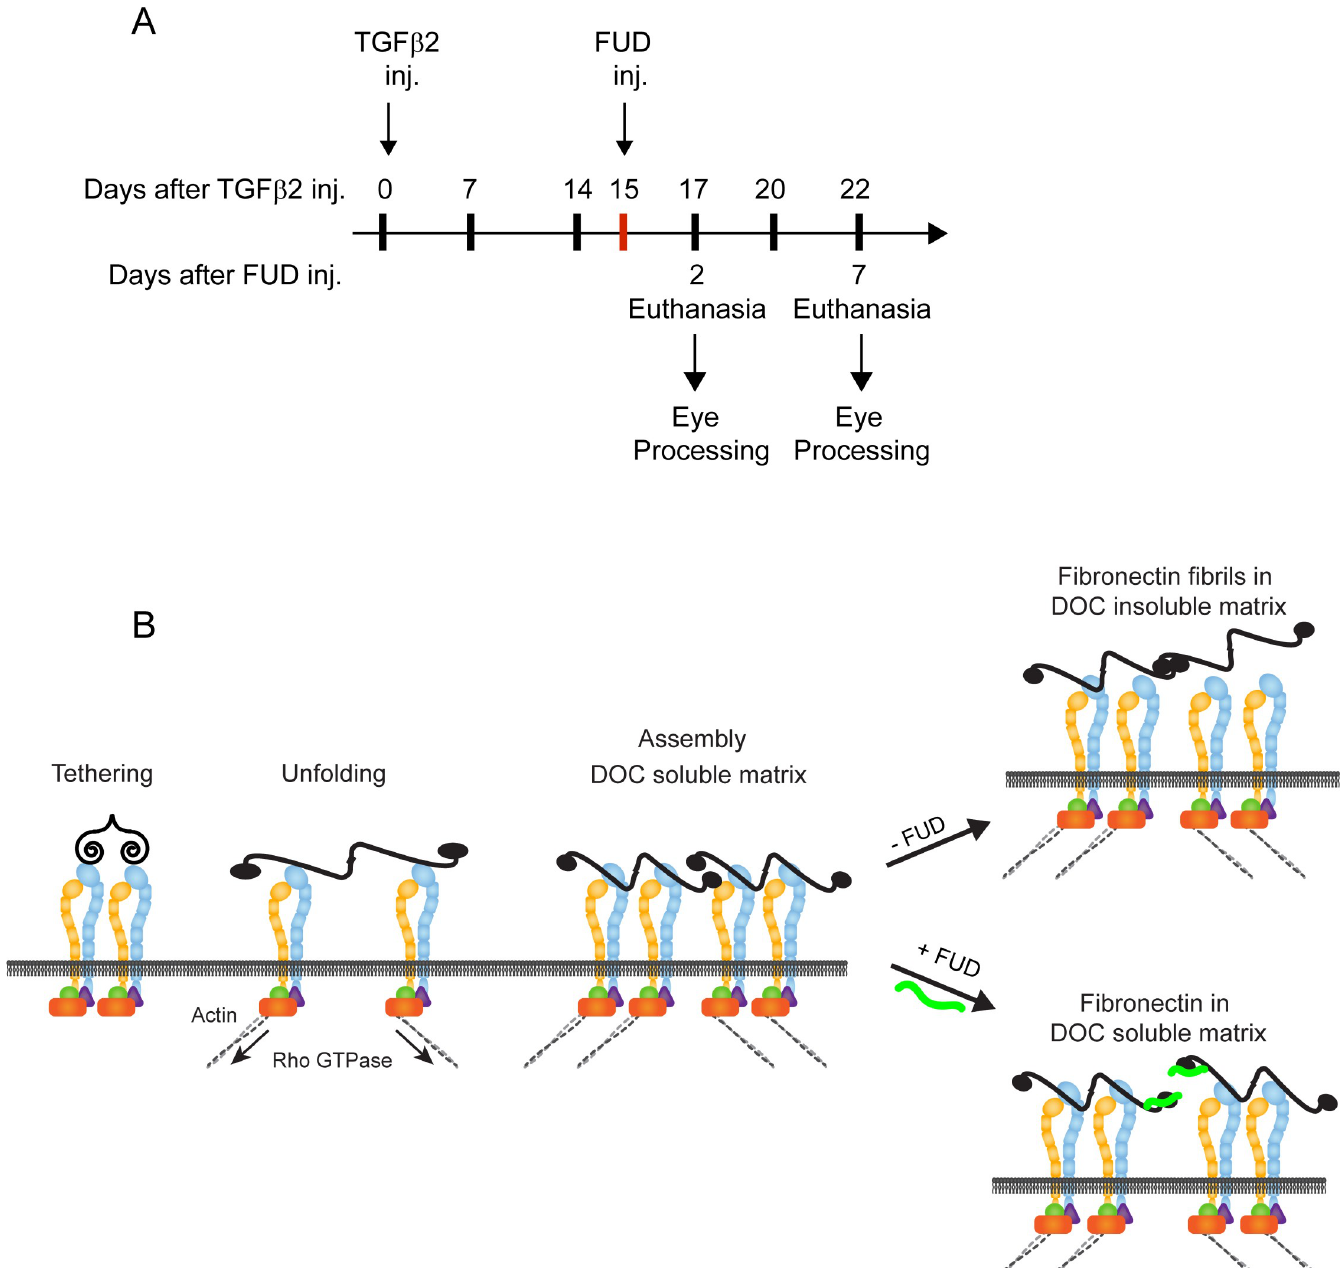
Fig 1. Treatment timeline and model for fibronectin matrix assembly. (A) Timeline showing which days IOP measurements were taken (black hash marks) and when Ad5-TGF β 2 (Day 0) or FUD (Day 15; red hash mark) was injected into the eye. Inj. = day injection was done. (B) The assembly of fibronectin into fibrils starts when a globular fibronectin dimer binds an integrin on the cell surface. Contractile forces applied from the actomyosin cytoskeleton via the integrins causes the fibronectin dimer to unfold, exposing fibronectin-fibronectin binding sites that mediate fibril formation. Additional fibronectin dimers are incorporated into the extracellular matrix creating a deoxycholate (DOC) insoluble fibril. FUD (green line) inhibits the additional incorporation of fibronectin into the extracellular matrix by blocking fibronectin-fibronectin binding sites necessary for fibril formation.